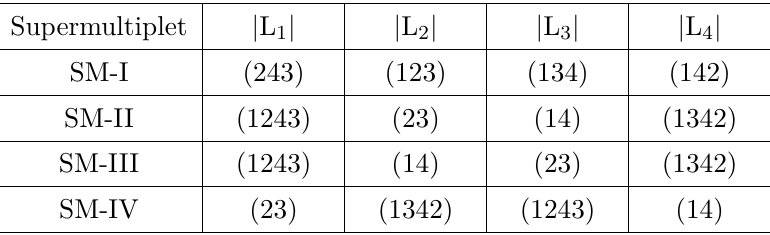
Table 1 . Supermultiplet Transformation Law/Permutation